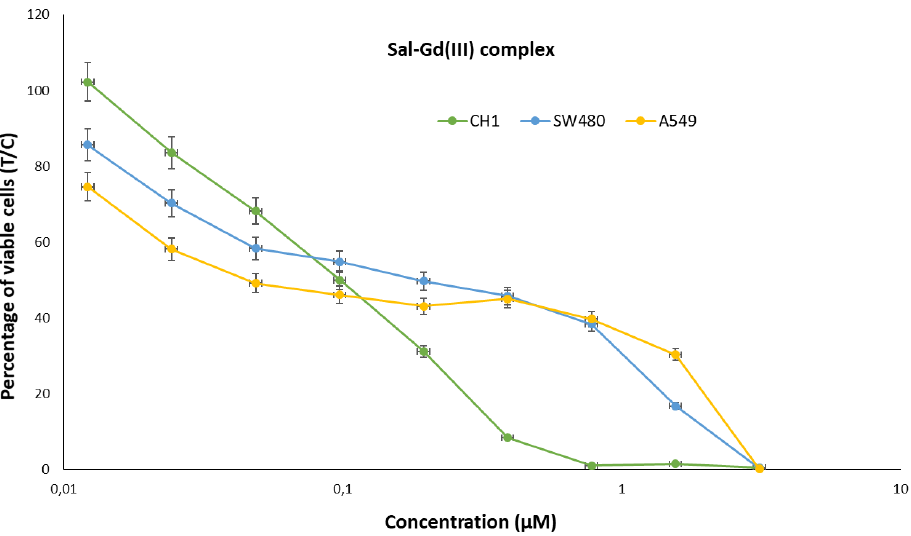
Figure 5. Concentration-effect curves of the Sal-Gd(III) complex in A549 (yellow), CH1/PA-1 (green), and SW480 (blue) cells, determined by the MTT assay after 96 h treatment. Values are normalized relative to untreated controls and represent means and standard deviations of at least three independent experiments. Table 1. Cytotoxicity evaluation of SalH, SalNa, free Gd(III) and Mn(II) salinomycinates, and with loaded BGs: mean IC 50 values (in µ M) ± standard deviations from at least three independent MTT assays in each of three human cancer cell